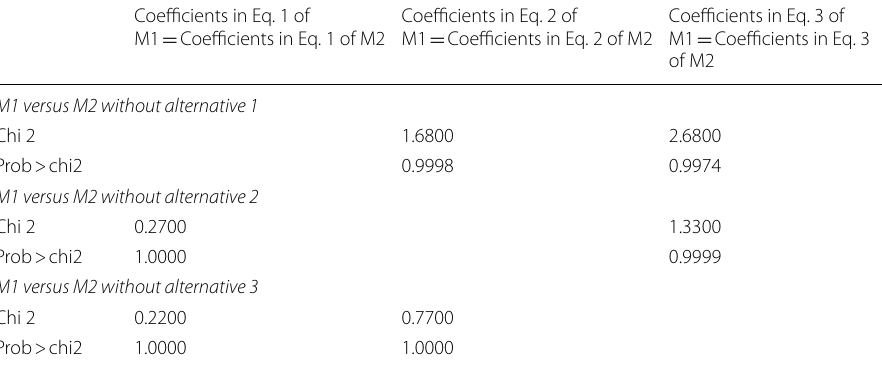
Table 7 Results of McFadden-Hausman IIA test / WAEMU Countries’ sample. Source : Author’s